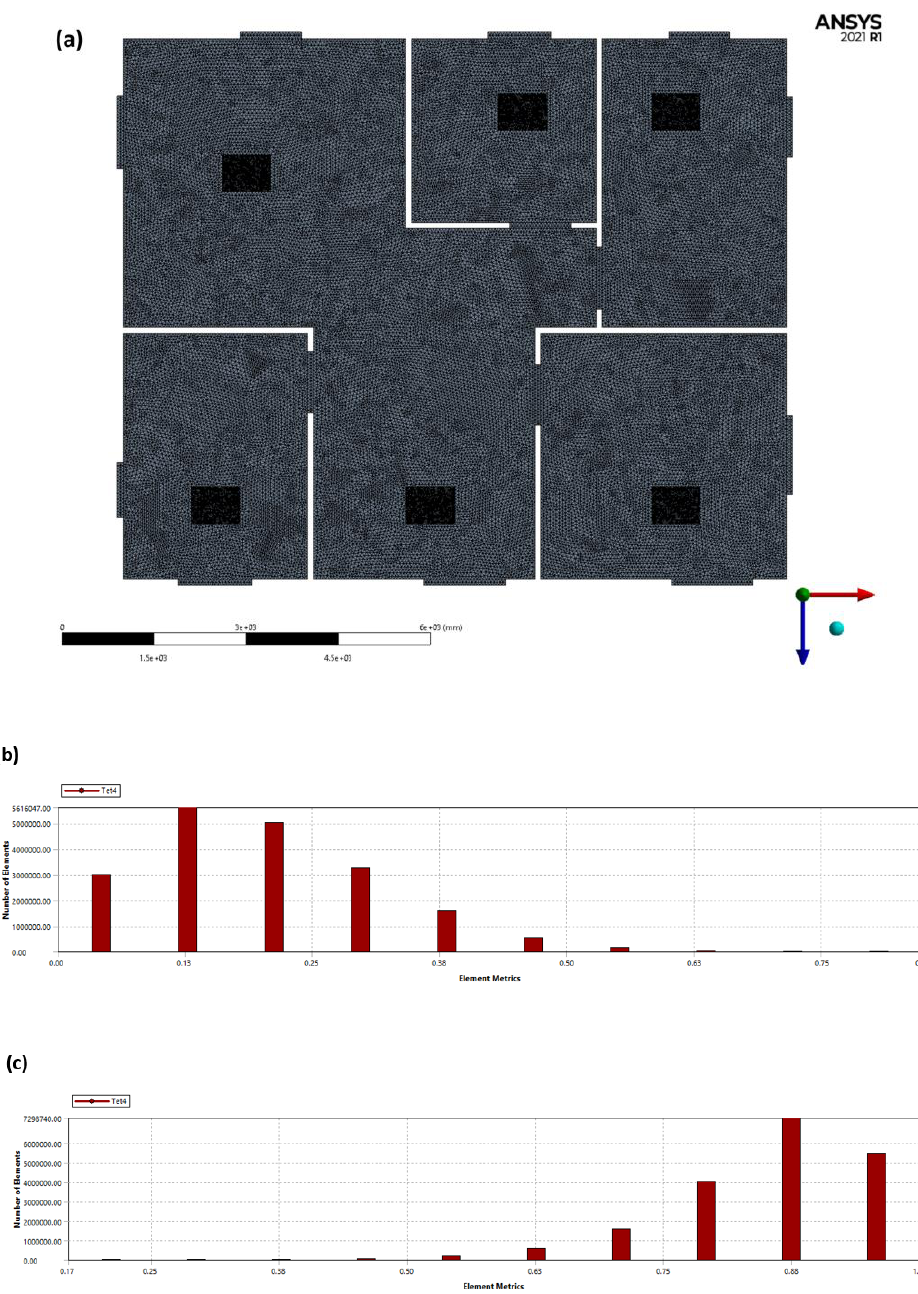
Figure 3. ( a ) The mesh geometry for the house (top-view), ( b ) the quality of the mesh showing the skewness and ( c ) the element quality.